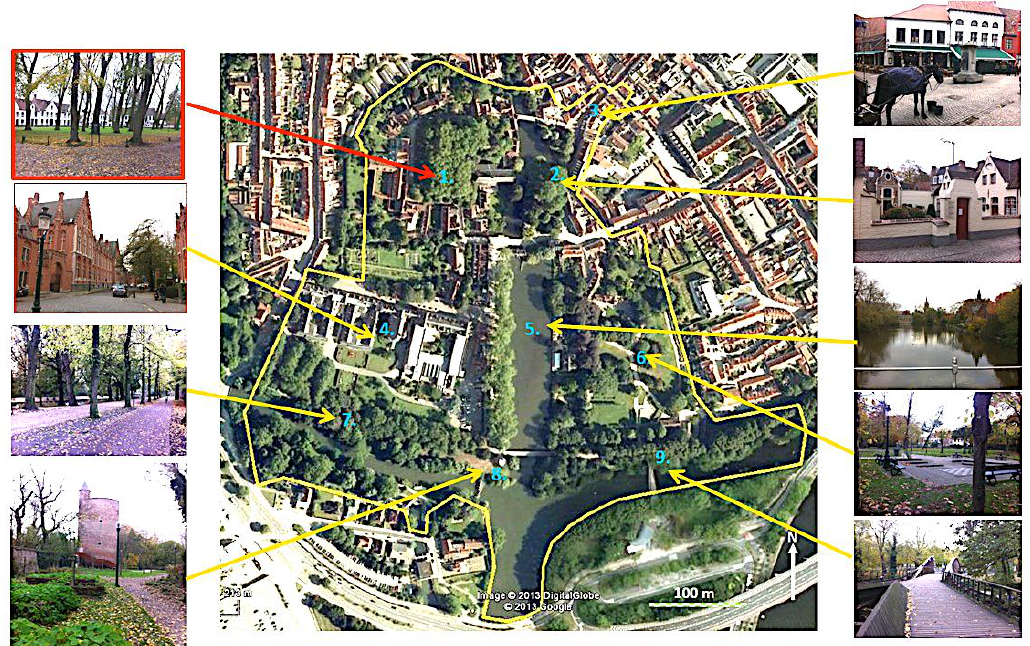
Figure 5. Minnewater site in Bruges, Belgium, Beguinage (red indicated).